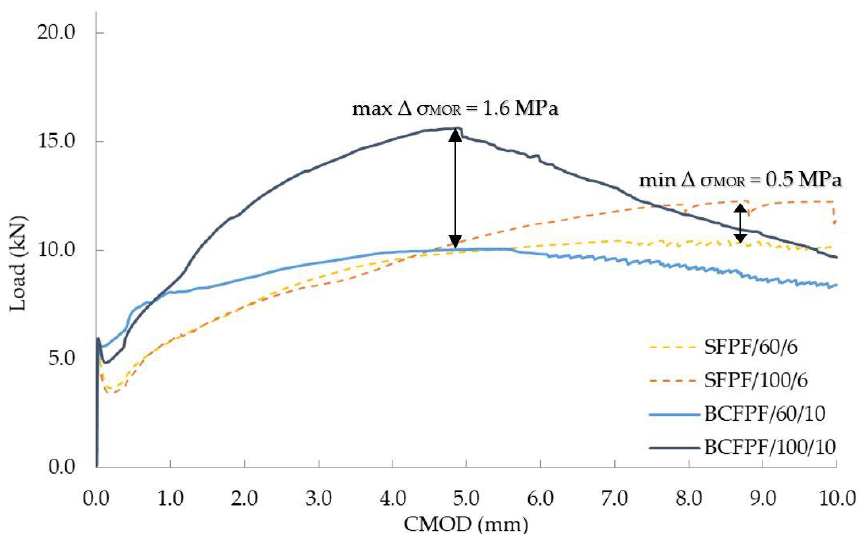
Figure 12. Load—CMOD (crack mouth opening displacement) relationship graphs showing the influence of fiber length on the obtained σ MOR stress values for fiber-reinforced soil-cement with a 450/1.2 matrix.